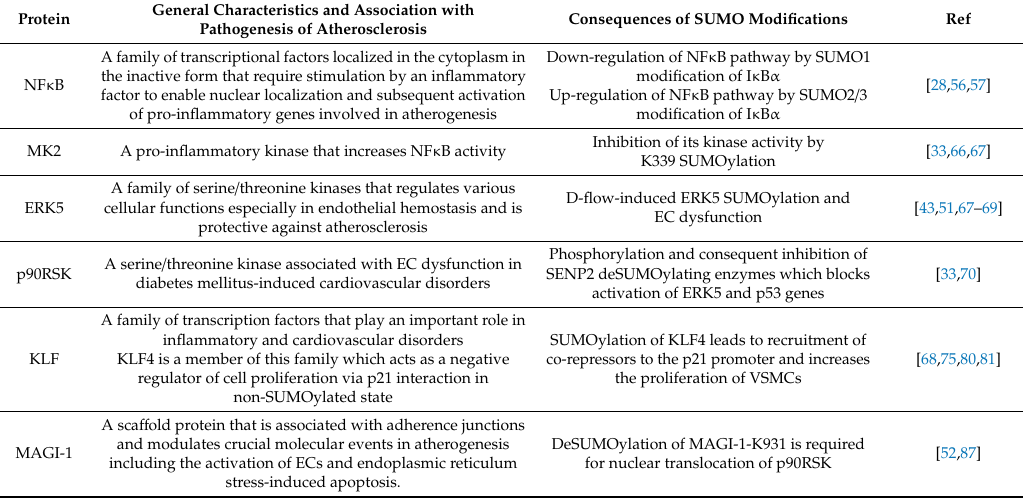
Summary of factors that a ff ected by SUMO modifications and are involved in atherosclerosis